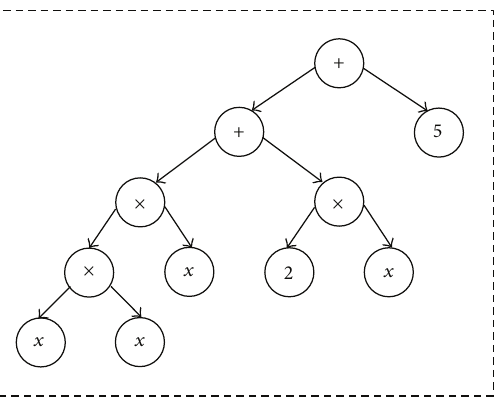
Figure 1: An example abstract-syntax tree corresponding to some function 𝑓 𝑖 (𝑥) = 𝑥 3 + 2𝑥 + 5 .